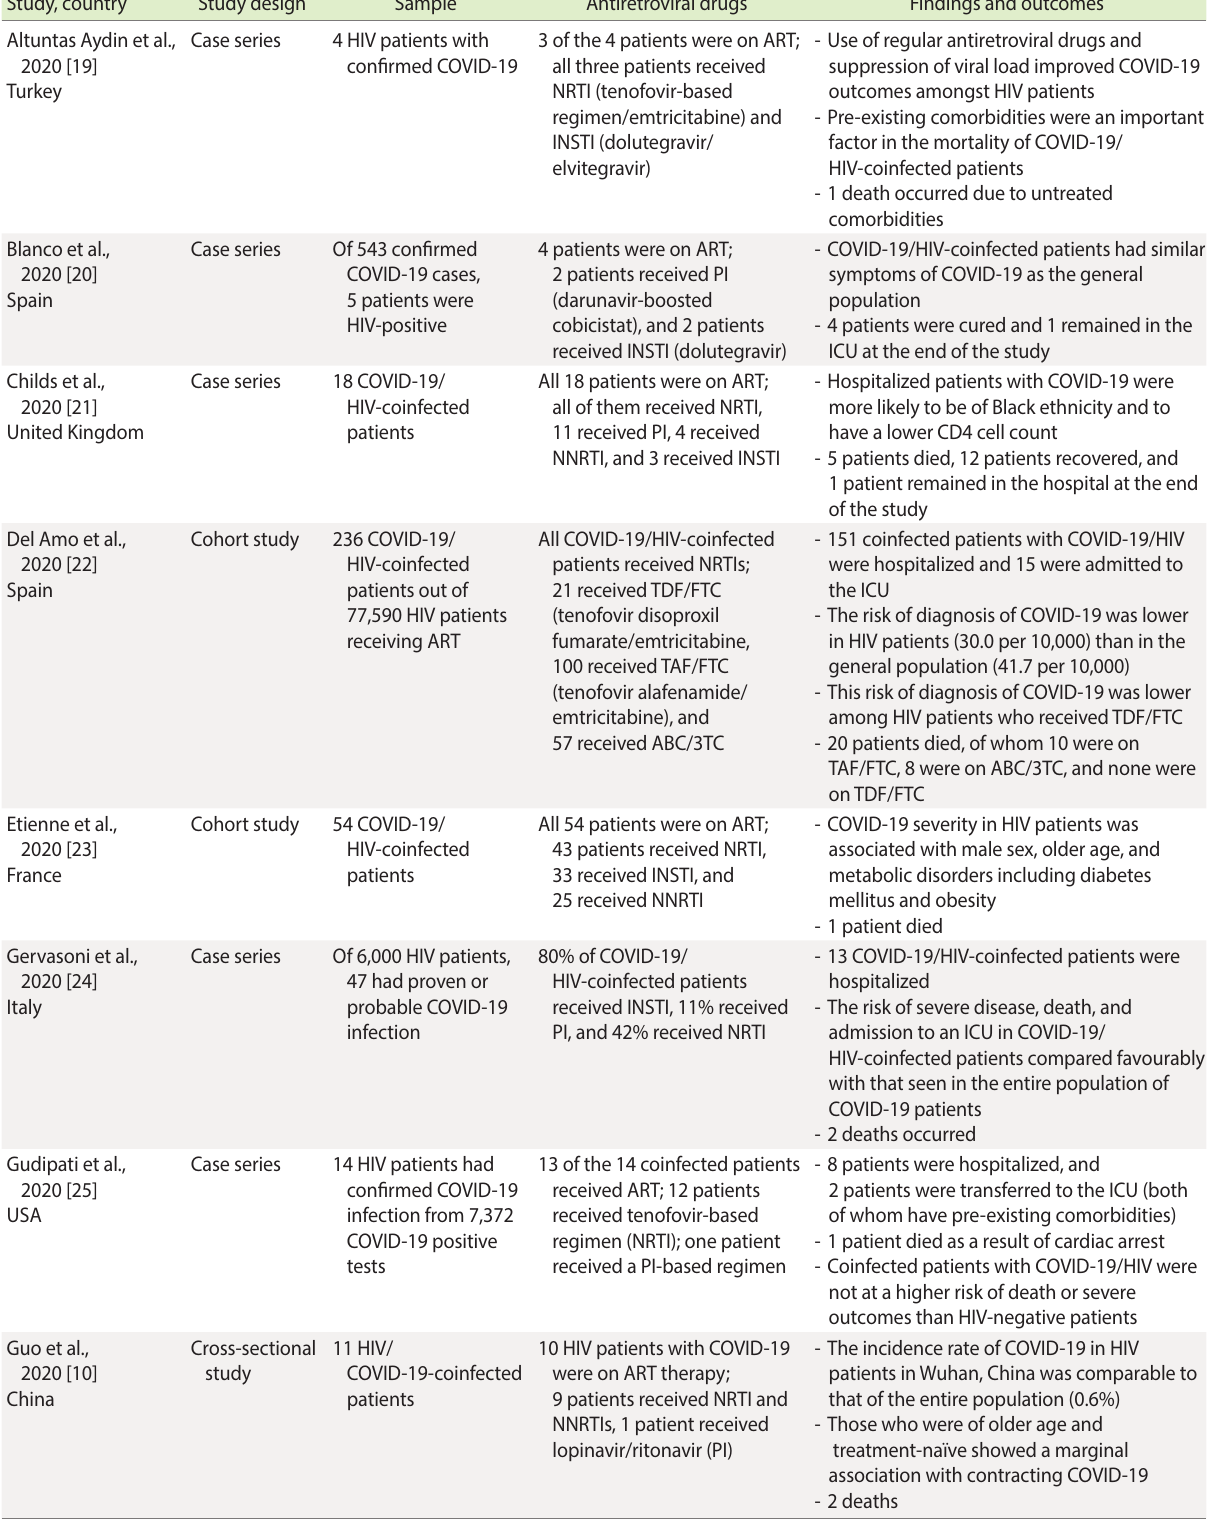
Table 2. Characteristics of the included